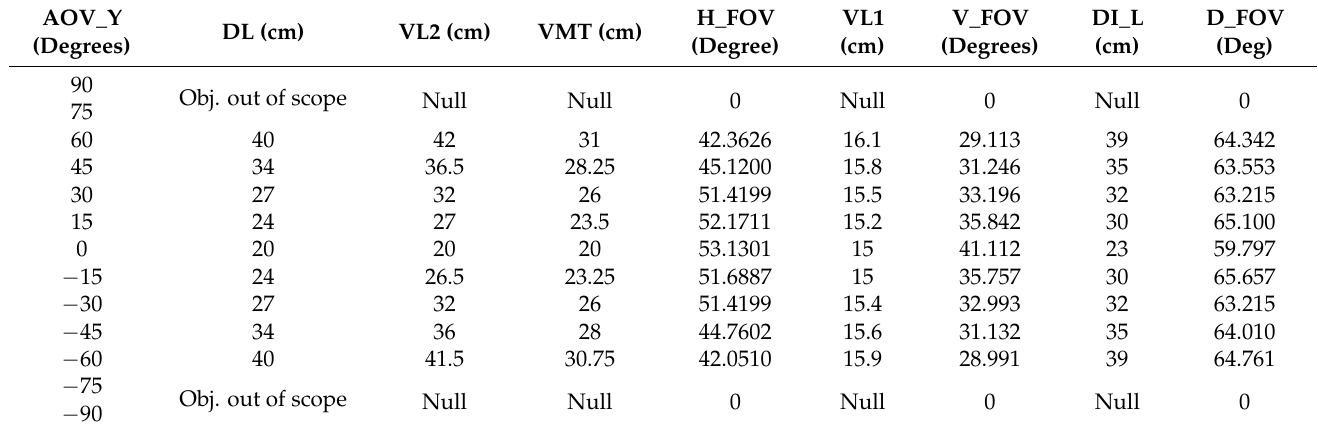
Table 3. Indoor FOV measurement with device position from the object (cm) and changing the camera in the y direction, Distance From Lens (DL), Horizontal Length (HL), Horizontal FOV (H_FOV), the Vertical Length of base 1 (VL1), the vertical length of base 2 (VL2), Vertical Median of Trapezoidal shown as OUT.